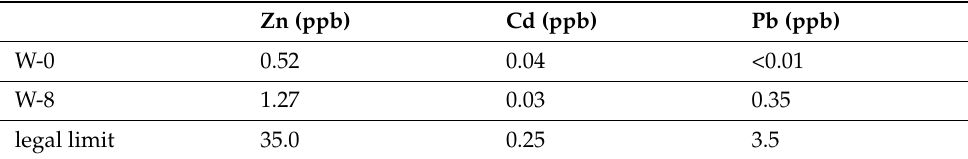
Table 4. Metal content levels in the leachates of samples W-0 and W-8 with the legal limit values (decree on waste).